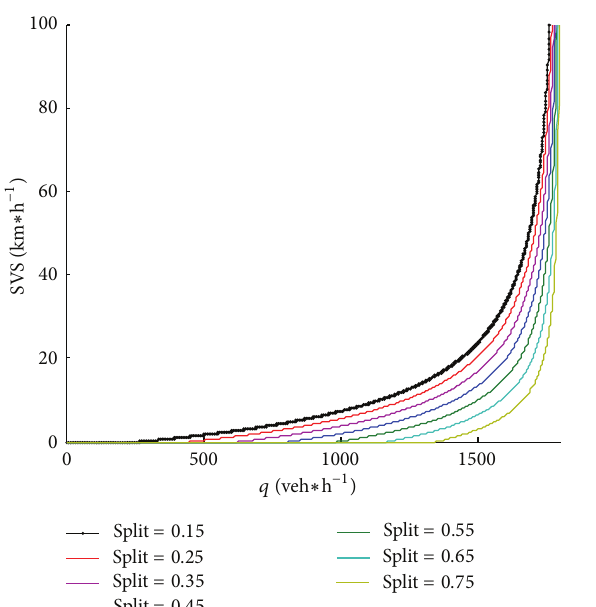
Figure 17: SVS versus arriving flow rate with triangular fundamen- tal diagram; 𝑘 𝑗 = 180 veh/km, 𝑞 𝑚 = 1800 veh/h, V 𝑓 = 50 km/h, and = 12.5 km/h. 𝑤 𝑎